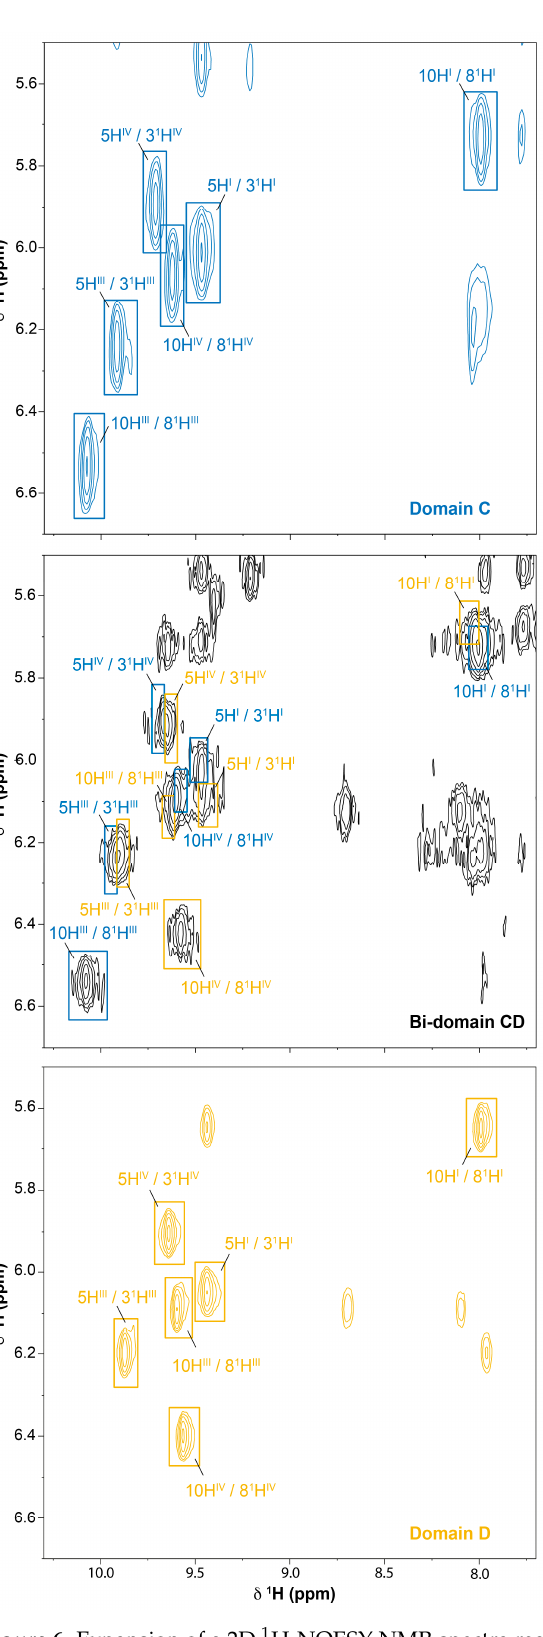
Figure 6. Expansion of a 2D 1 H-NOESY NMR spectra region of domain C (blue), domain D (yellow) and bi-domain CD (black) highlighting the meso/thioether methine NOE connectivities (pH 8 and 288 K). All spectra were acquired with 80 ms mixing-time. The spectra were recorded on a spectrometer operating at a proton frequency of 600 MHz.